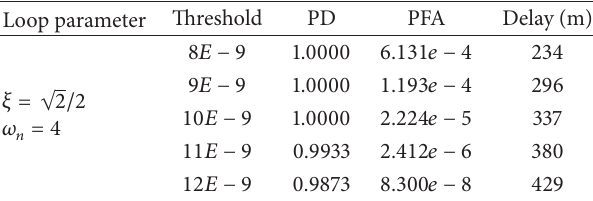
Table 2: Detection performance for frequency